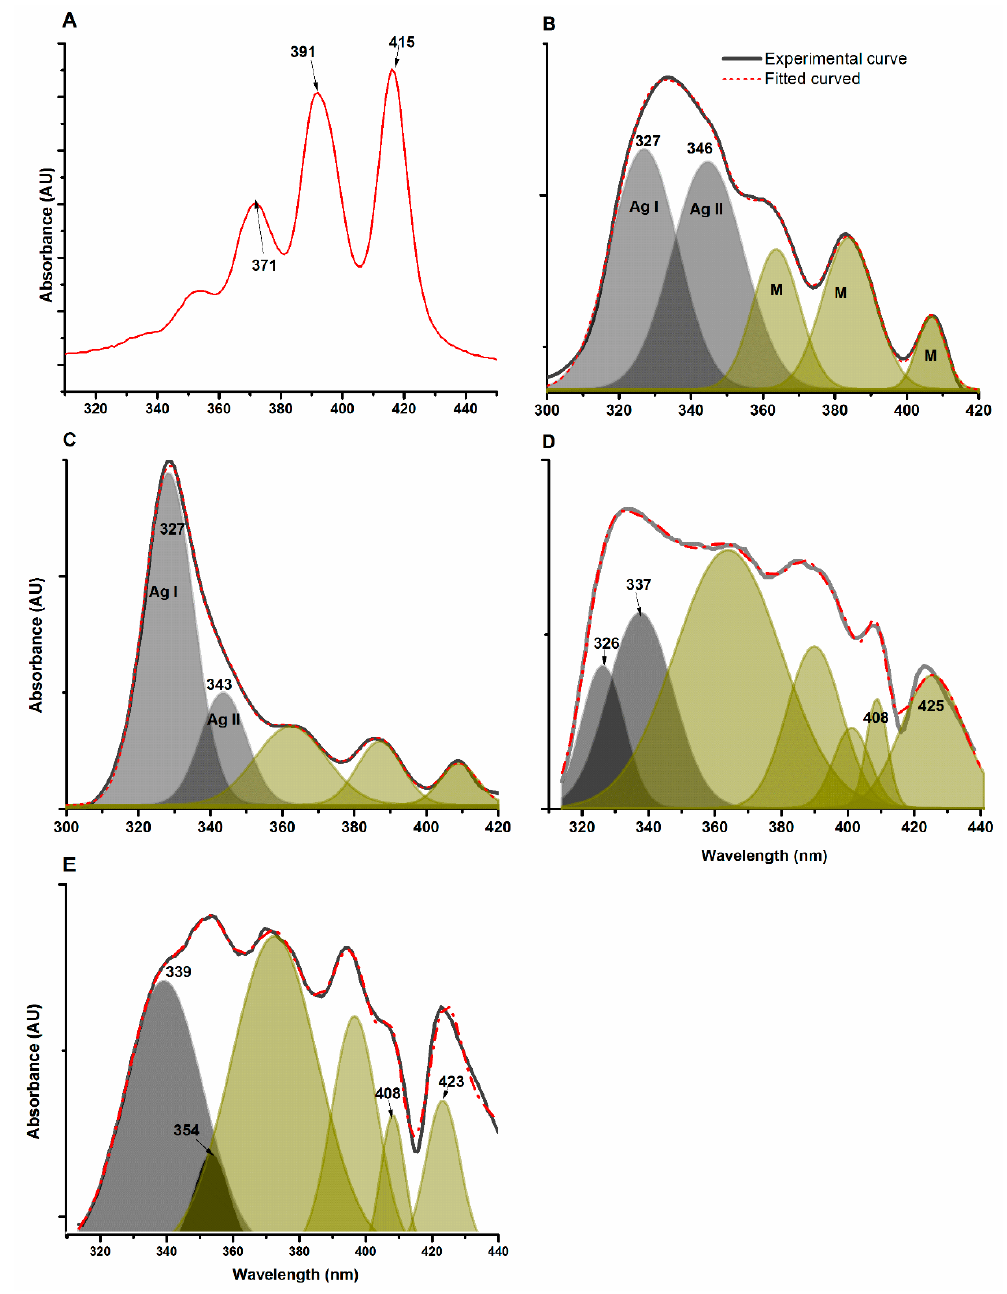
Figure 5. UV–vis spectrum of AmB dissolved in PBS ( A ) in water ( B ), Fungizone ® ( C ), AmB@ABA ( D ) and AmB@ABA-RET ( E ). The spectra were fitted to Gaussian peaks to allow for the separation of absorption peaks due to two types of aggregates, designated as AI and AII, and the monomeric form (M).